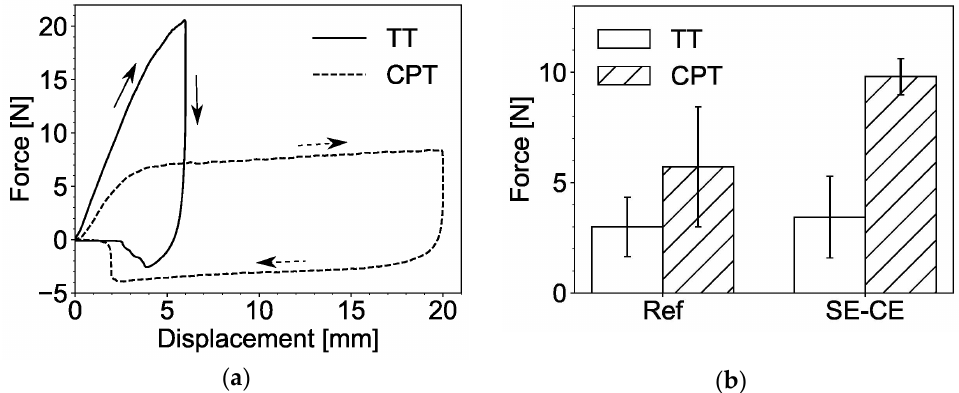
Figure 11. Tack test ( TT ) and cylinder pull test ( CPT ): ( a ) typical force-displacement diagrams, and ( b ) comparison between the results for the mixtures Ref and SE-CE.